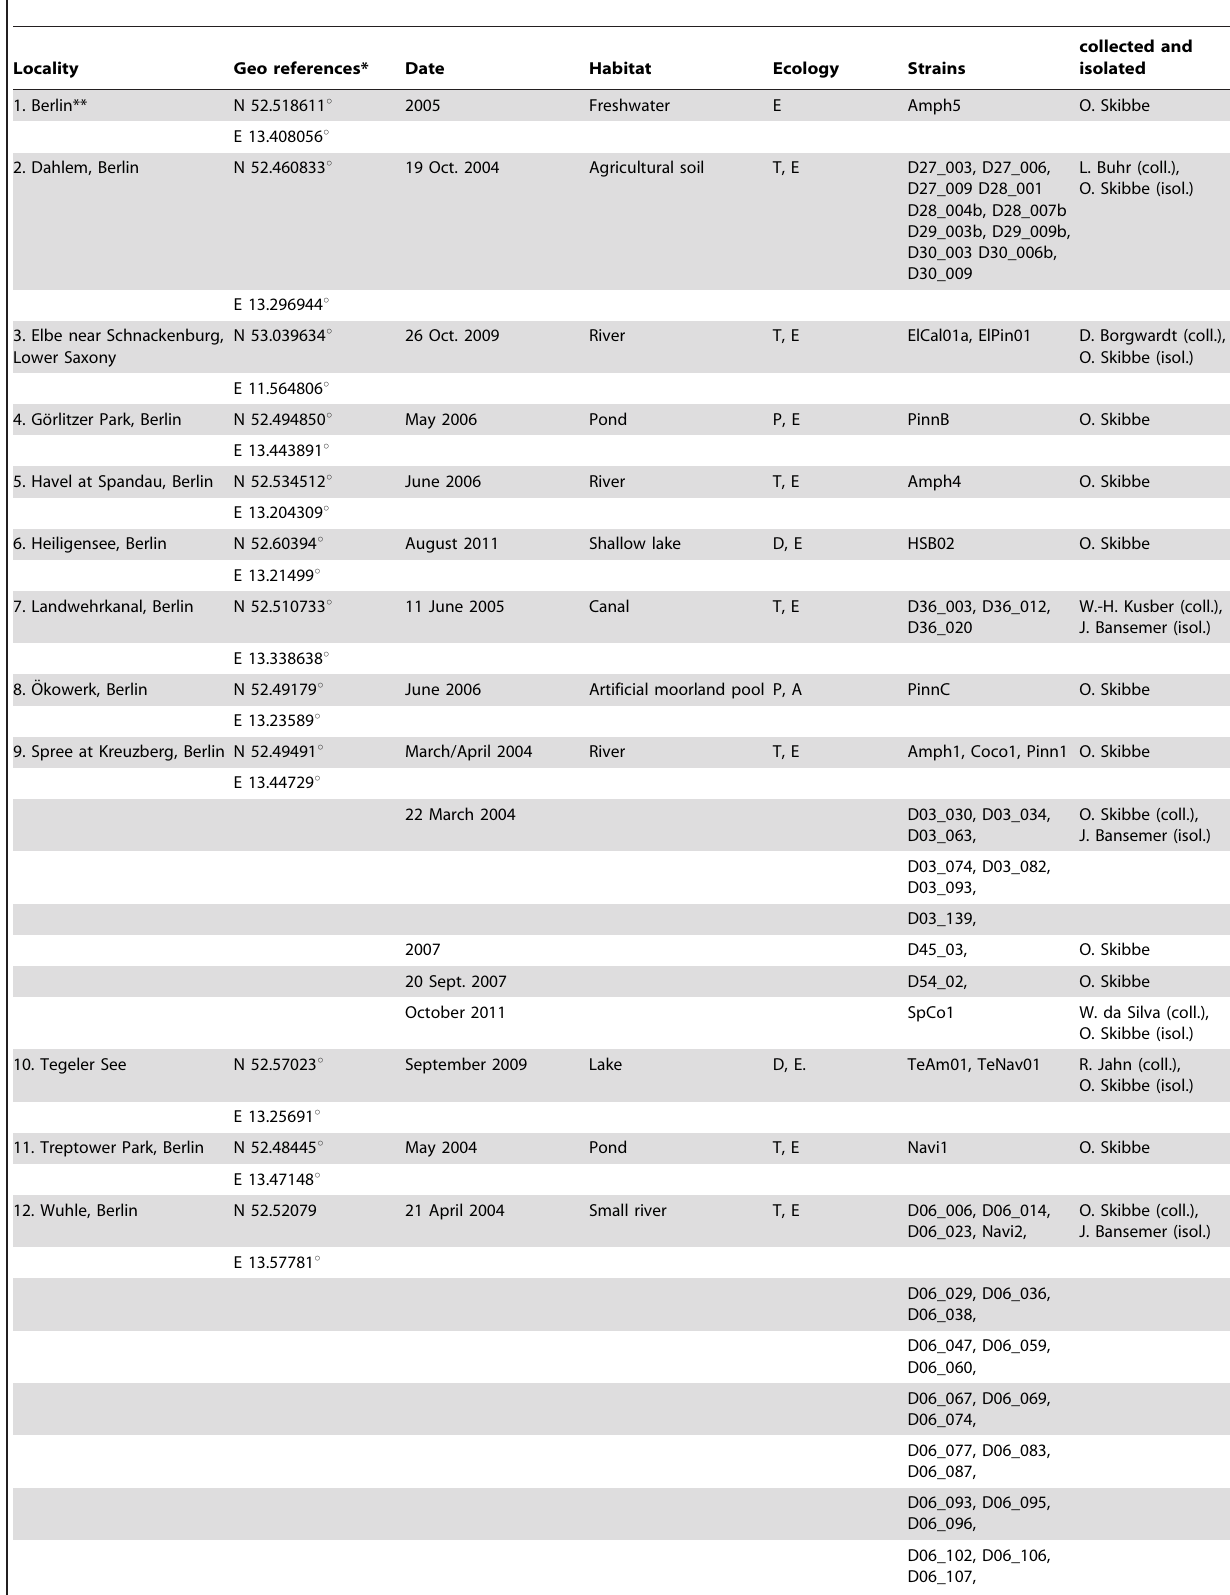
Table 1. List of Localities: Strain Numbers, Geo-Reference, Habitat, Ecology.